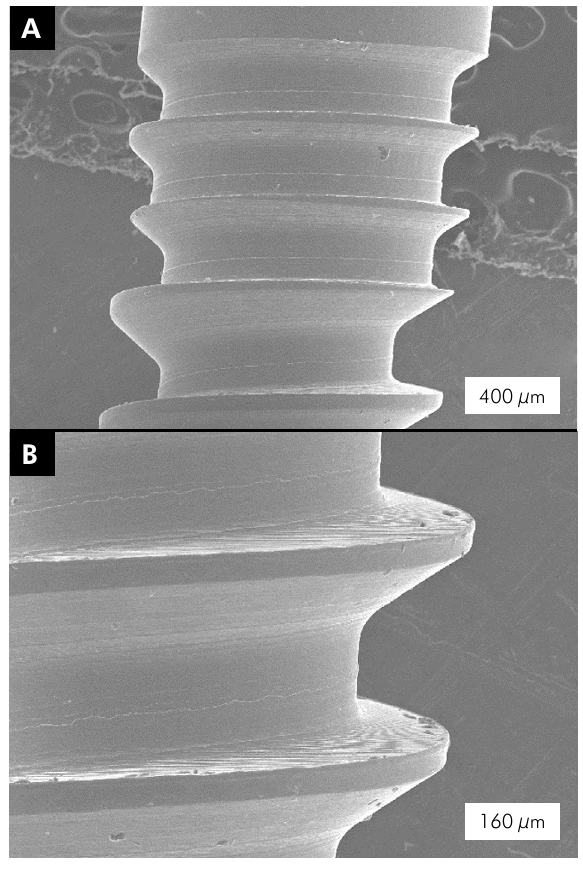
Figure 1. (A) Photomicrograph of retrieved MI, showing it’s morphology with microthreads in the portion close to the trans- mucosal neck. (B) Larger magnification of the microthreads.